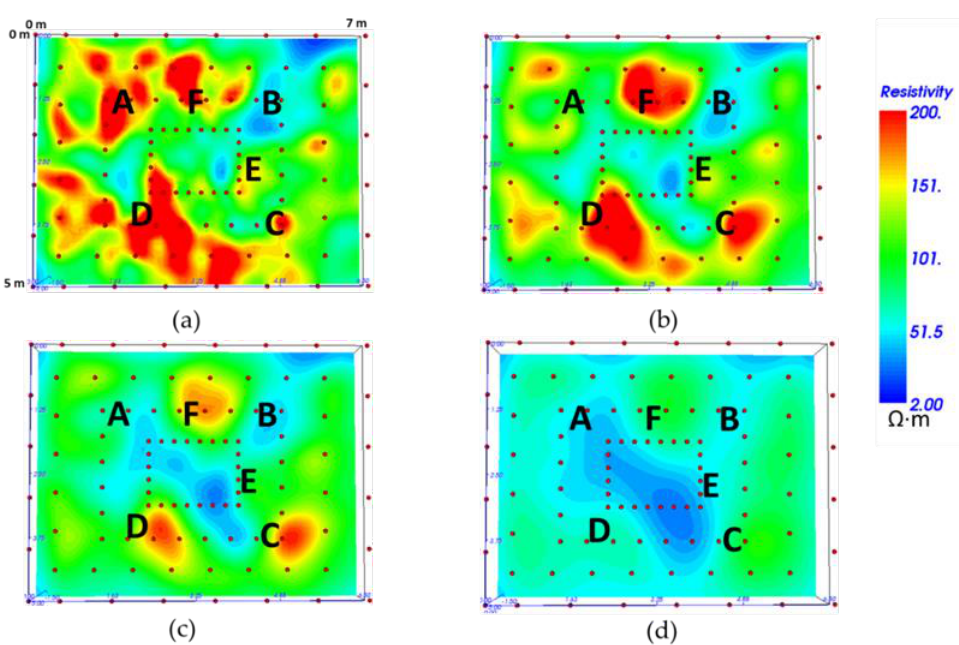
Figure 10. 3D loop – loop ERT depth-slices at 0.25 m ( a ), 0.45 m ( b ), 0.70 m ( c ), and 1.00 m ( d ) at WL3.